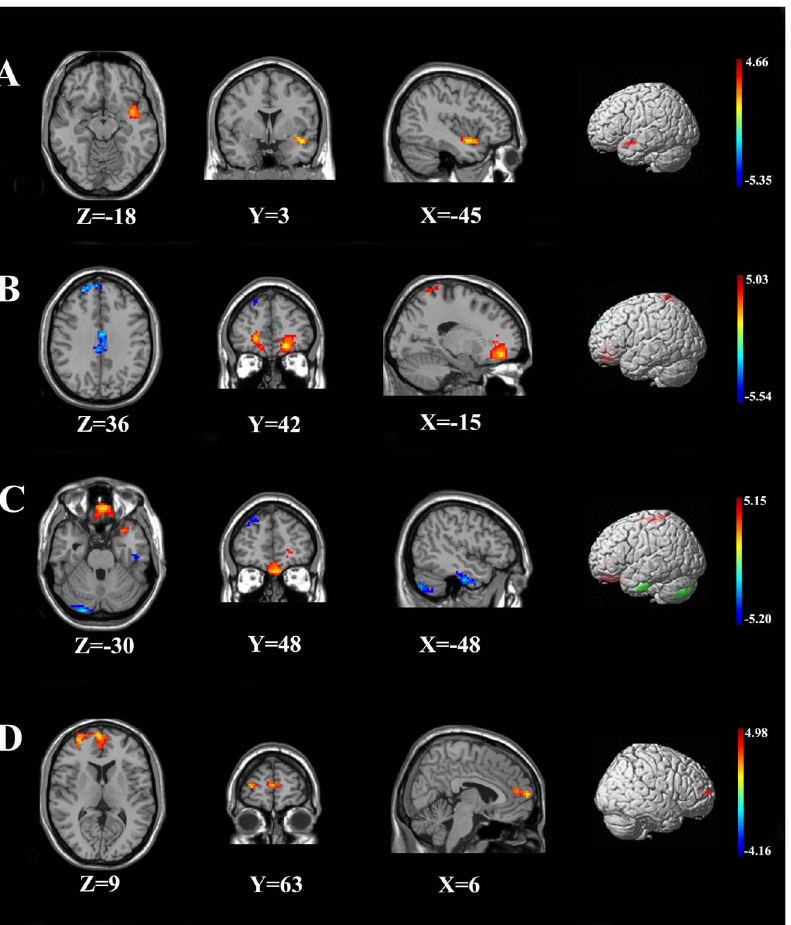
Figure 2. Statistical Parametric Images of Between-Group Functional Connectivity Analysis for ESRD Patients and Controls. Panels A demonstrated enhanced functional connectivity in superior temporal gyrus (Red) in ESRD patients when the seed areas were located in the left dorsal lateral prefrontal cortex ([Brodmann’s area 10], panels B demonstrated reduced functional connectivity in bilateral cerebellum posterior lobe, left inferior temporal gyrus, right dlPFC (Blue), and enhanced functional connectivity in bilateral OFC, left posterior gyrus (Red) in ESRD patients when the seed areas were located in the right dorsal lateral prefrontal cortex ([Brodmann’s area 11], panels C demonstrated reduced functional connectivity in bilateral cerebellum posterior lobe, right dlPFC, bilateral ACC (Blue), enhanced FC in bilateral OFC, bilateral superior parietal lobe (Red) when the seed areas were located in the medial orbito-frontal cortex ([Brodmann’s area 10, 11, 32], and panels D demonstrated enhanced functional connectivity in right medial PFC (Red) in ESRD patients when the seed areas were located in the left middle temporal gyrus [Brodmann’s area 10, 11, 32].